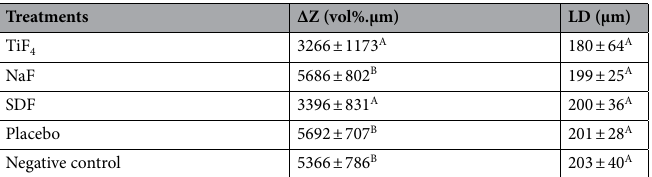
Table 1. Mean and standard deviation of the integrated mineral loss (ΔZ, vol% μm) and lesion depth (LD, μm) presented by the demineralized dentin samples. Different letters in the same column indicate significant differences among the treatments. ANOVA and Tukey–Kramer test (ΔZ p < 0.0001; LD p = 0.3986).